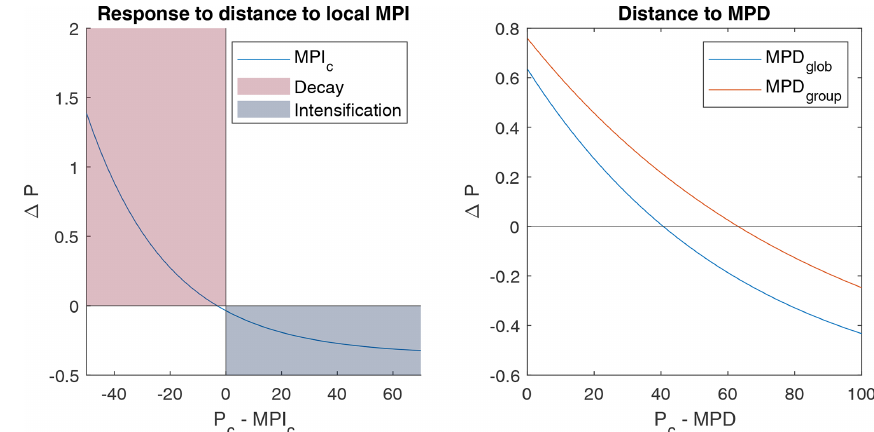
Figure 9. Response of the depression dynamics model to distance to thermodynamic potentials over intensification factor domains (hPa).